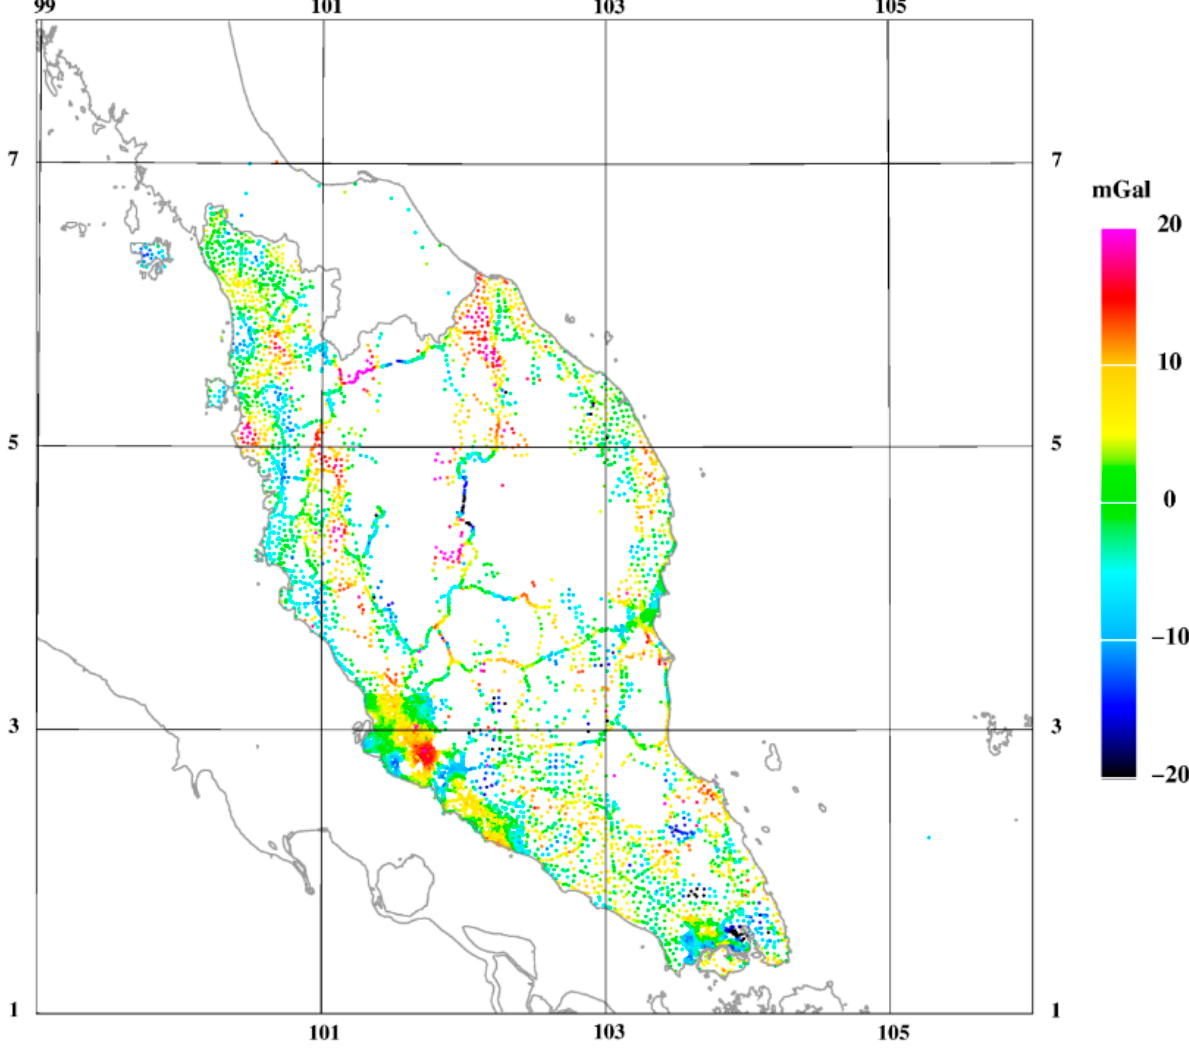
Figure 10. Terrestrial gravity data after XGM2019 and RTM terrain reduction.